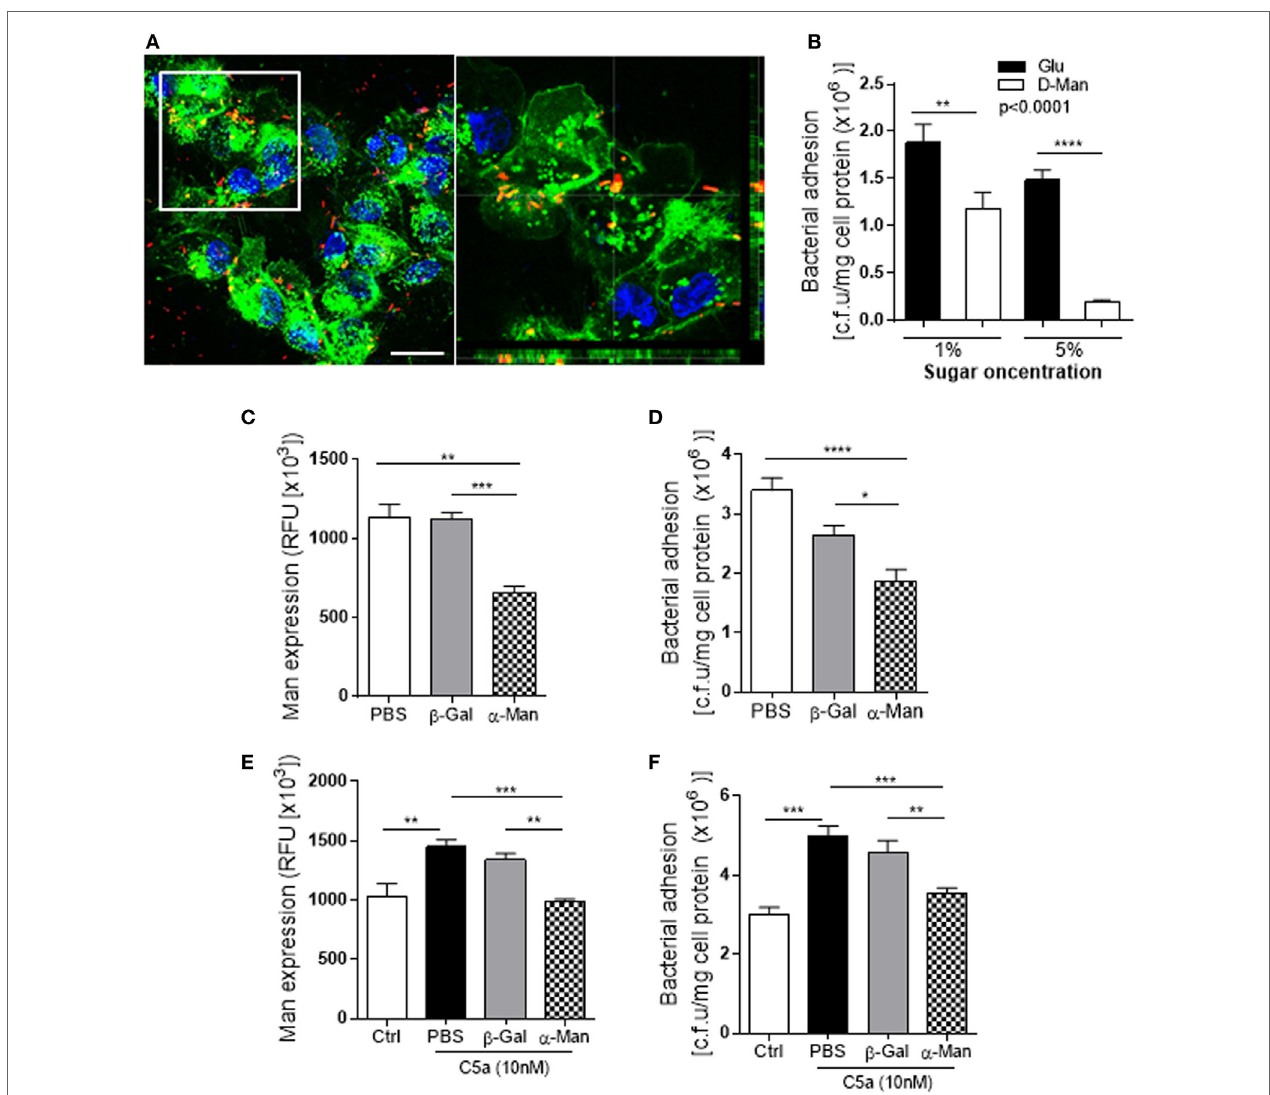
FigUre 5 | Uropathogenic Escherichia coli adhesion to renal tubular epithelial cell (RTEC) through binding to Man on the cell surface of the RTEC. (a) Confocal microscopic images of bound bacteria in RTEC (non-permeabilized) that had been incubated with labeled J96 for 1 h. Bacteria (red), Man (green) detected by fluorescein-labeled Galanthus nivalis lectin and 4’,6-diamidino-2-phenylindole (blue) are shown. Left image: compressed image. Scale bars, 10 µm. Right image: corresponding to the boxed region in the left image show the cross-sectional views in z stack (bottom and side panel) of RTEC, Man, and bacteria, demonstrating association of Man and J96 at cell surface of RTEC. (B) Bacteria binding to RTEC, evacuated by bacterial plate count assay. RTEC were incubated with d -mannose or glucose (1 or 5%) for 30 min before the addition of bacteria. Data were analyzed by two-way ANOVA with multiple comparisons ( n = 8 individual wells per group). (c,e) Man expression in RTCE that had been pre-treated without C5a (c) or with C5a (e) for 24 h and then treated with buffer alone (PBS) or containing α - mannosidase (5 mM) or control enzyme ( β -galactosidase) for 1 h, evacuated by fluorescence intensity-based microplate assay. Data were analyzed by one-way ANOVA with Tukey’s multiple comparisons ( n = 6 individual wells per group). (D,F) Bacterial binding to RTEC that had undergone the same treatments as described in (c,e) , evacuated by bacterial plate count assay. (D) Without C5a pre-treatment. (F) With C5a pre-treatment. Data were analyzed by one-way ANOVA with Tukey’s multiple comparisons ( n = 8 individual wells per group). * P < 0.05, ** P < 0.01, *** P < 0.001, **** P < 0.0001. All results shown are representative of three independent